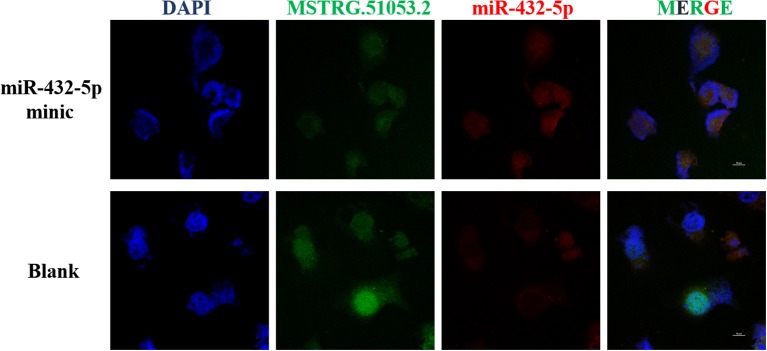
(A,B) The target sites of MSTRG51053.2 and MGST3 binding to miR-432-5p. (C) The luciferase activity of MSERG.5105.2-wild type was significantly inhibited in the miR-432-5p-transfected HEK293 cells. However, miR-432-5p transfection exhibited no inhibitory effect on the luciferase activity of MSERG.5105.2-mutant. (D) The luciferase activity of MGST3-wild type significantly decreased in the miR-432-5p-transfected HEK293 cells. However, miR-432-5p transfection exhibited no inhibitory effect on the luciferase activity of MGST3-mutant. ***P < 0.001.